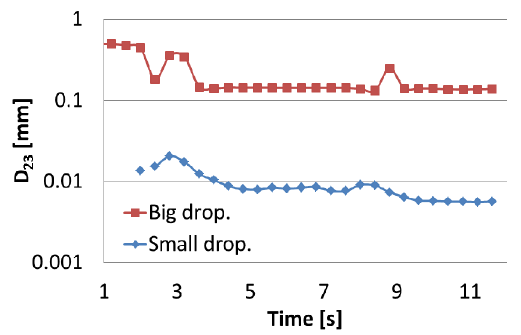
Fig. 10. Time evolution of the Sauter mean diameter for measurement with detergent.